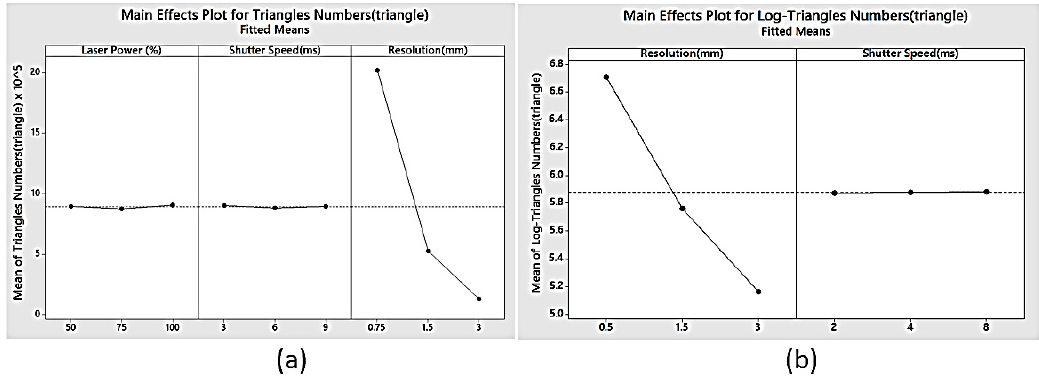
Figure 16. Main effect plots for triangle numbers: ( a ) laser scanner; ( b ) white light scanner. Appl. Sci. 2018 , 8 , x